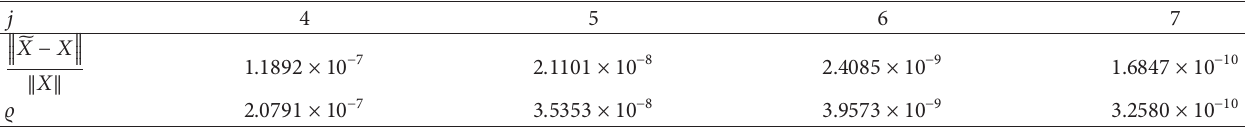
Table 4: Results for Example 3 with different values of j.